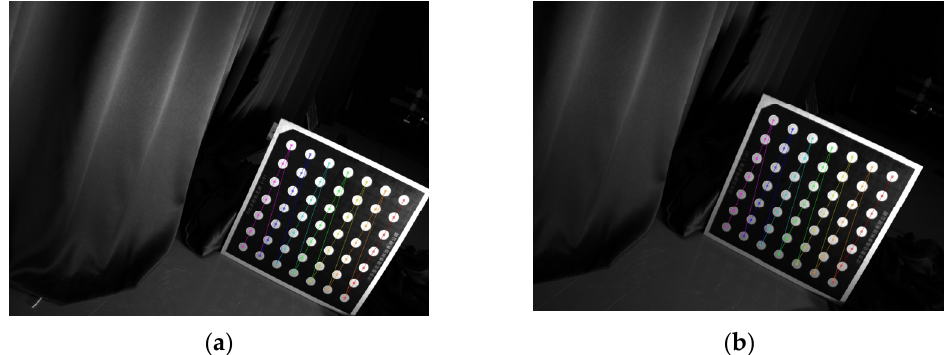
Figure 4. The extraction results of the circle center of the calibration plate in the left and right cameras: ( a ) left image; ( b ) right image.